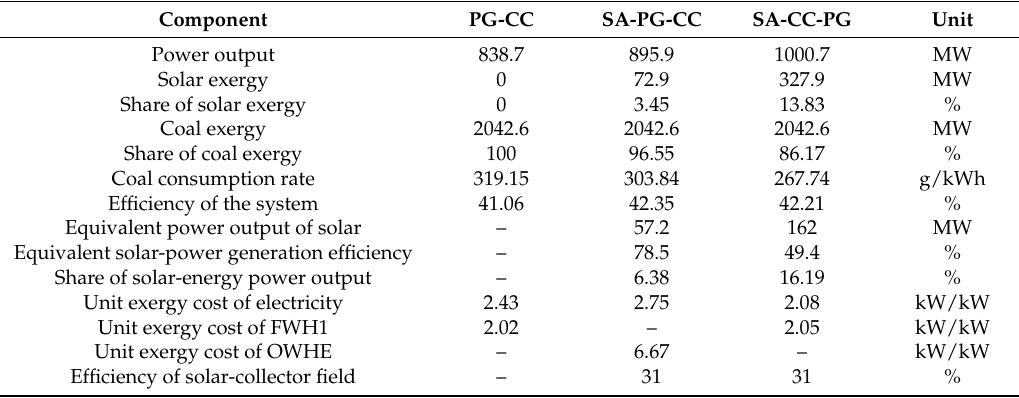
Table 7. Primary results of exergy analysis for coal-fired power-generation system with MEA-based CO 2 capture (PG-CC), solar-aided coal-fired power generation with CO 2 capture (SA-PG-CC) and solar-aided CO 2 capture coal-fired power generation